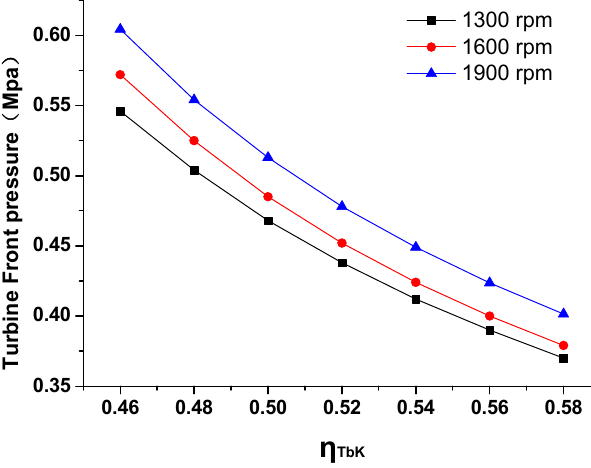
Figure 2. Relationship between the total turbocharger efficiency and the turbine front pressure.